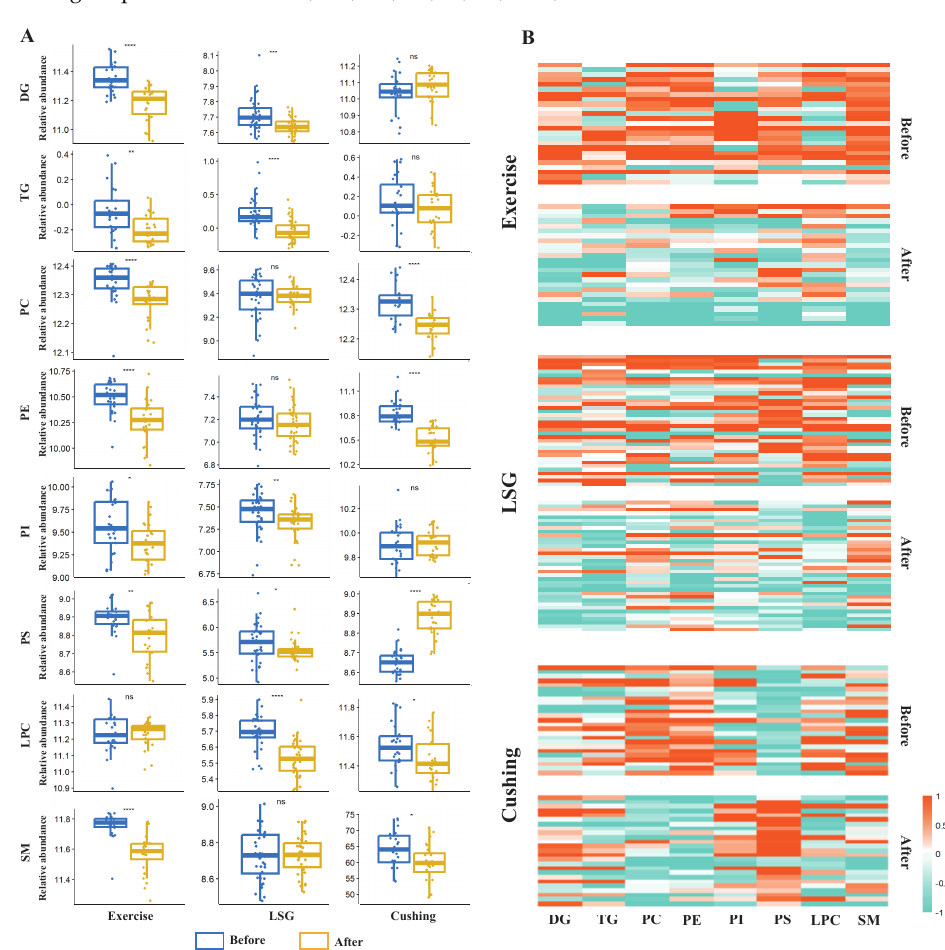
Figure 3. Changes in lipid subclasses. ( A ) Boxplot of relative concentrations of eight lipid subclasses which show significant differences between exercise or surgical interventions. Wilcoxon Signed Rank Test, ns: p > 0.05, *: p ≤ 0.05, **: p ≤ 0.01, ***: p ≤ 0.001, ****: p ≤ 0.0001. ( B ) Heatmap of relative concentrations of eight lipid